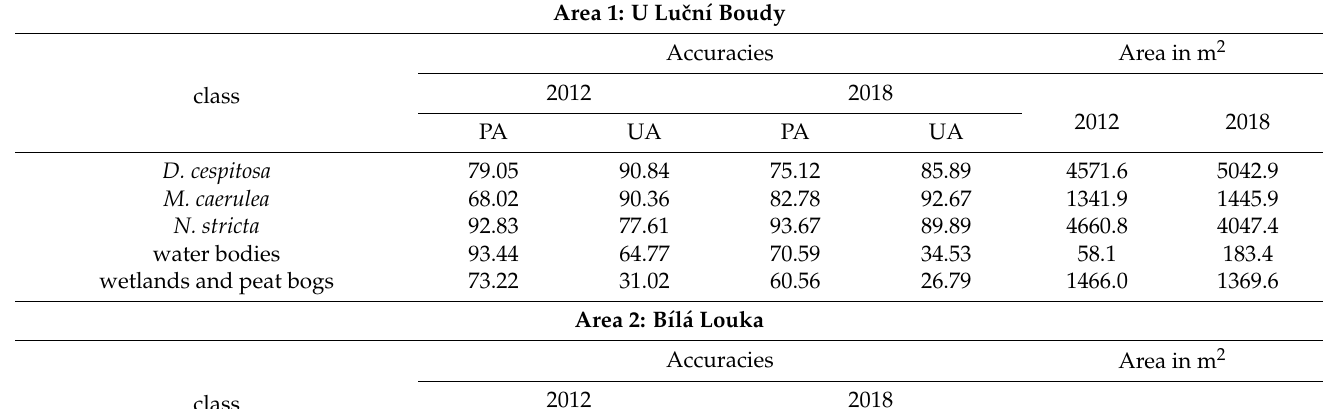
Table 1. Producer and user accuracies for classified species and the area of the species in 2012 and 2018 (PA = Producer accuracy, UA = user accuracy).